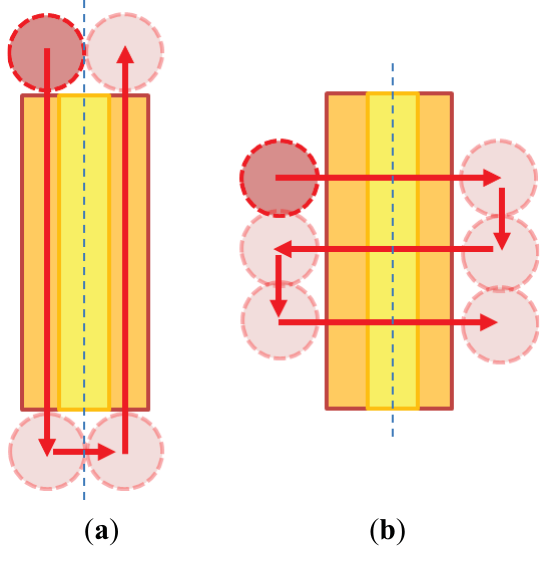
Figure 3. Schematic of the laser processing path: ( a ) parallel machining; and ( b ) vertical